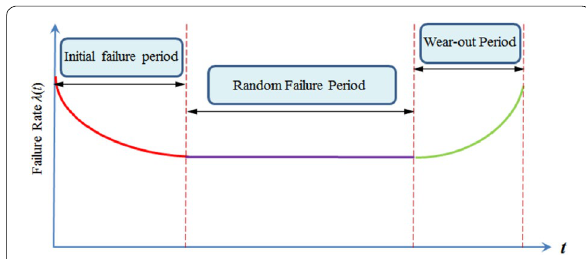
Figure 7 Failure rate with respect to